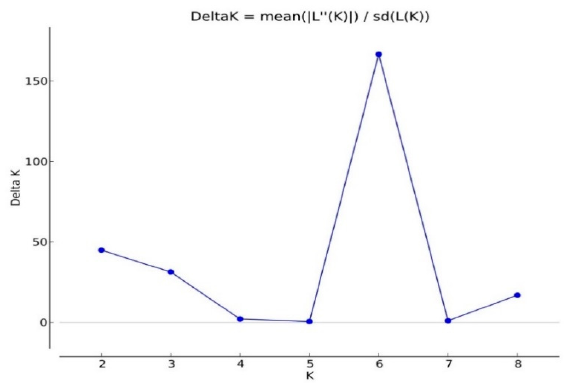
Figure 2. Delta K for 132 accessions.